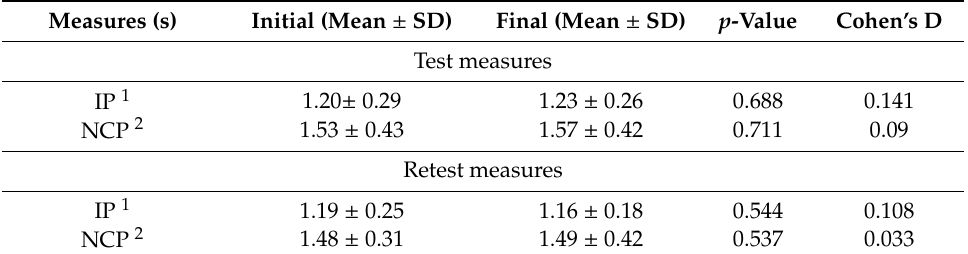
Table 3. Impulse phase and non-contact phase comparison between initial and final repetition in the test and retest.